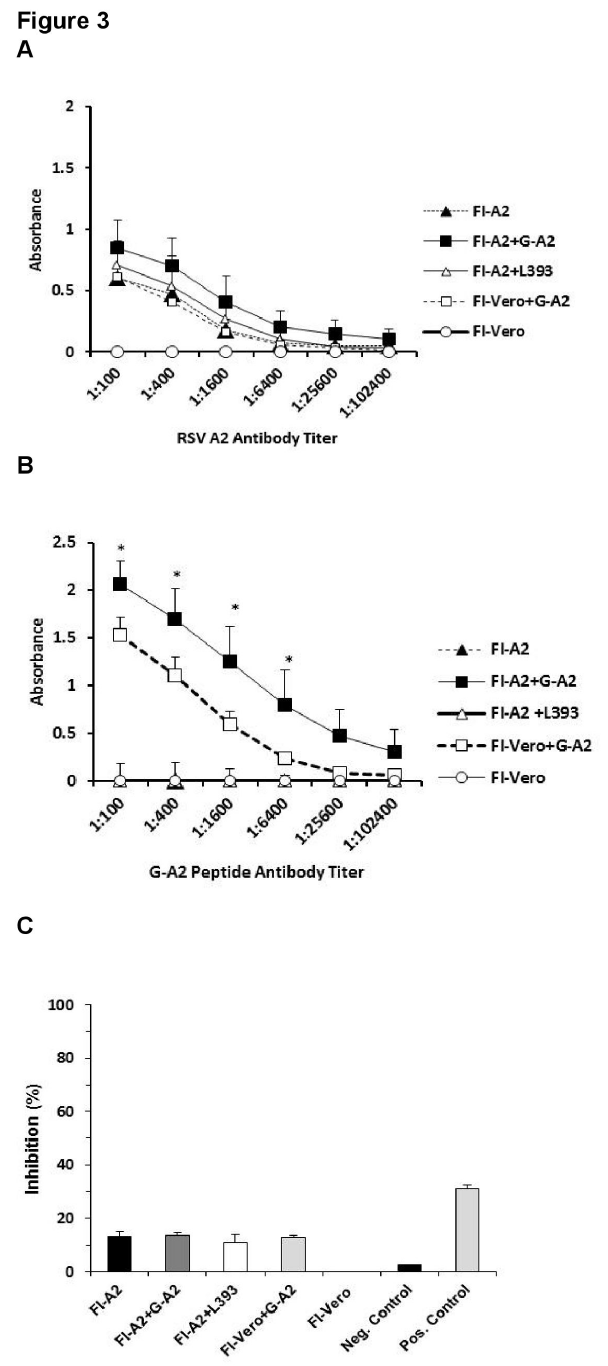
Figure 3. Antibody response against immunizing G peptides in FI-A2 vaccinated mice. Two weeks following the final boost and prior to RSV challenge, whole RSV A2 IgG specific titers (A) and G-A2 peptide specific IgG titers (B) in sera from mice vaccinated with formalin-inactivated RSV A2 alone (FI-A2), FI-A2 and RSV A2 G peptide (FI-A2+G-A2), FI-A2 and control L393 peptide (FI-A2+L393), FI-Vero alone (FI-Vero), or FI-vero and RSV A2 G peptide (FI-Vero+G-A2) were detected by indirect ELISA. Shown are the absorbance values (OD ) after subtraction of background OD values against control antigen. Results are means 405 405 of 5 to 10 mice per group and are representative of three independent experiments. (C) Neutralizing antibodies against live RSV A2 in vaccinated animals (1:200 dilution) were detected by a microneutralization assay. Serum from a naïve mouse and anti-RSV F monoclonal antibody (143-6C) were used as negative and positive controls, respectively. * p<0 . 05 . doi: 10.1371/journal.pone.0083075.g003 PLOS ONE |